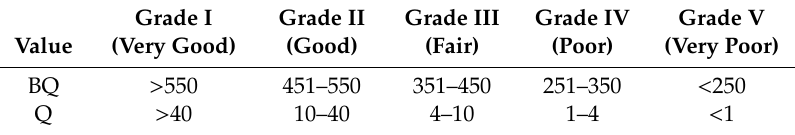
Table 3. Relationship between the basic quality (BQ) system and the quality (Q) System.